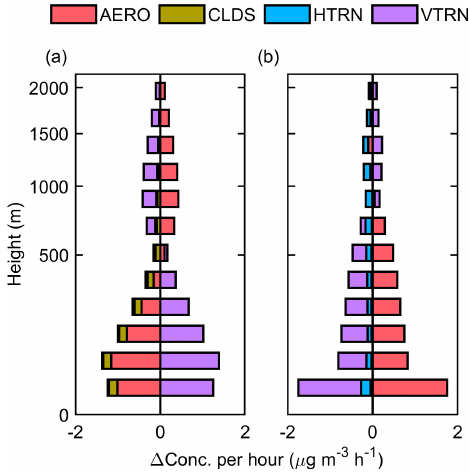
Figure 8. The monthly mean of vertical distribution of main pro- cess of nitrate in January (a) and July (b)